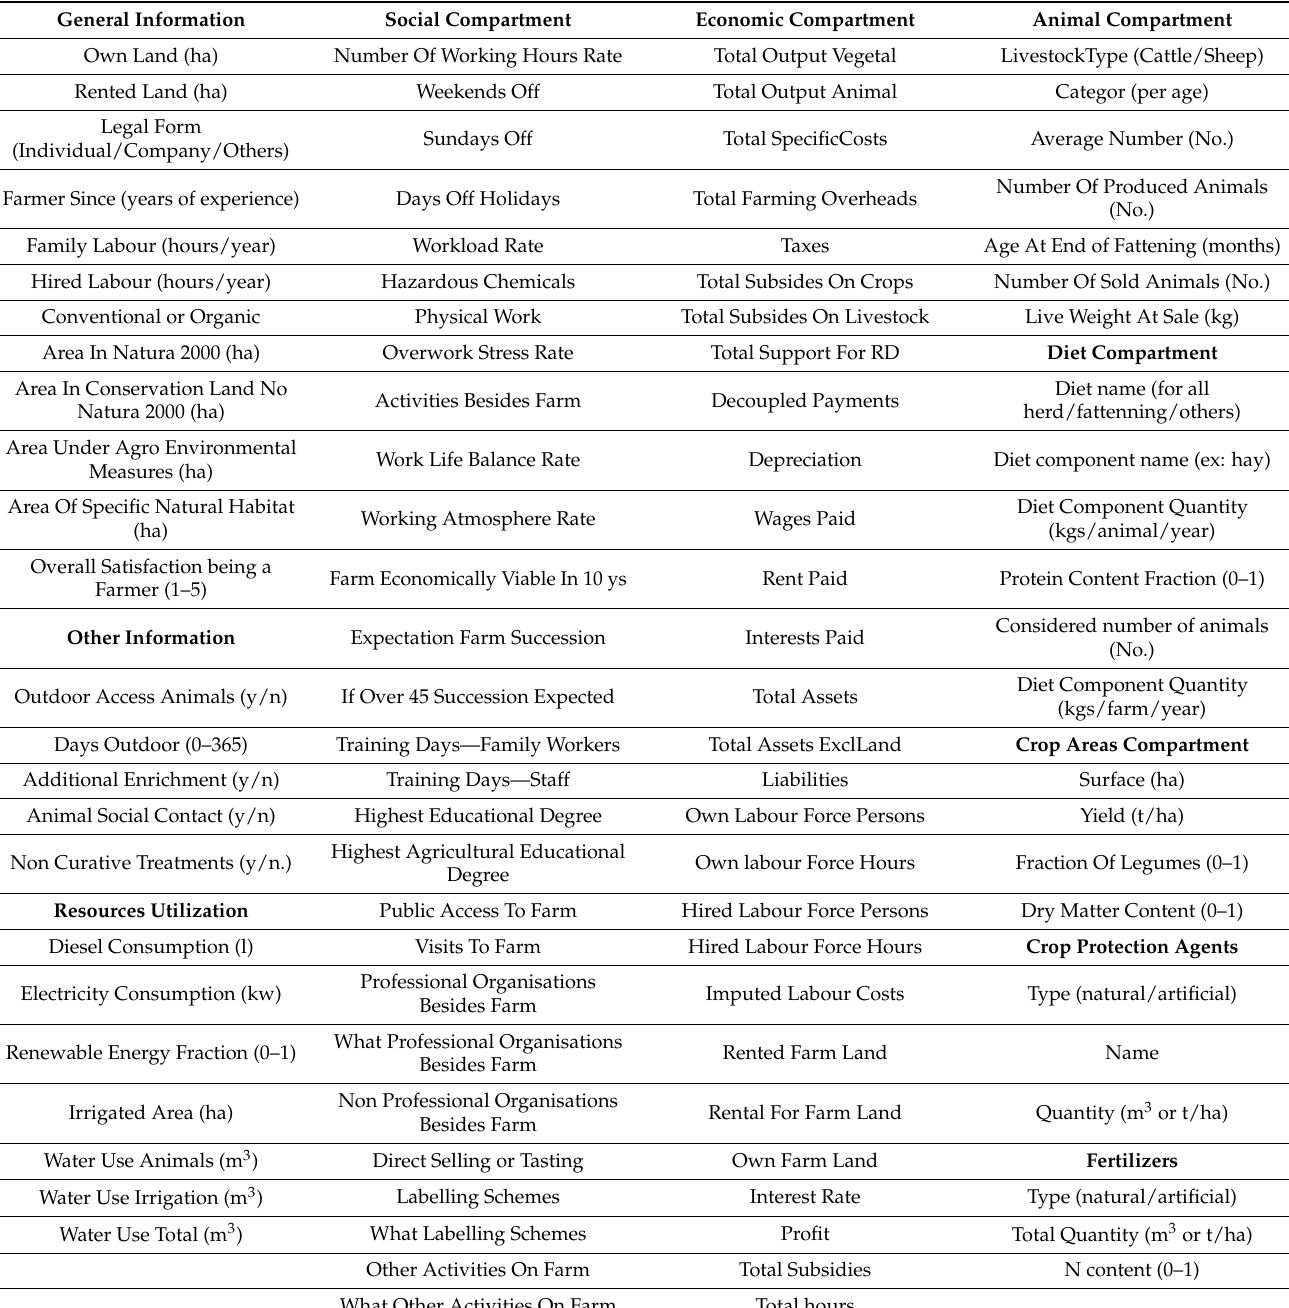
Table A1. Animal future Questionnaire